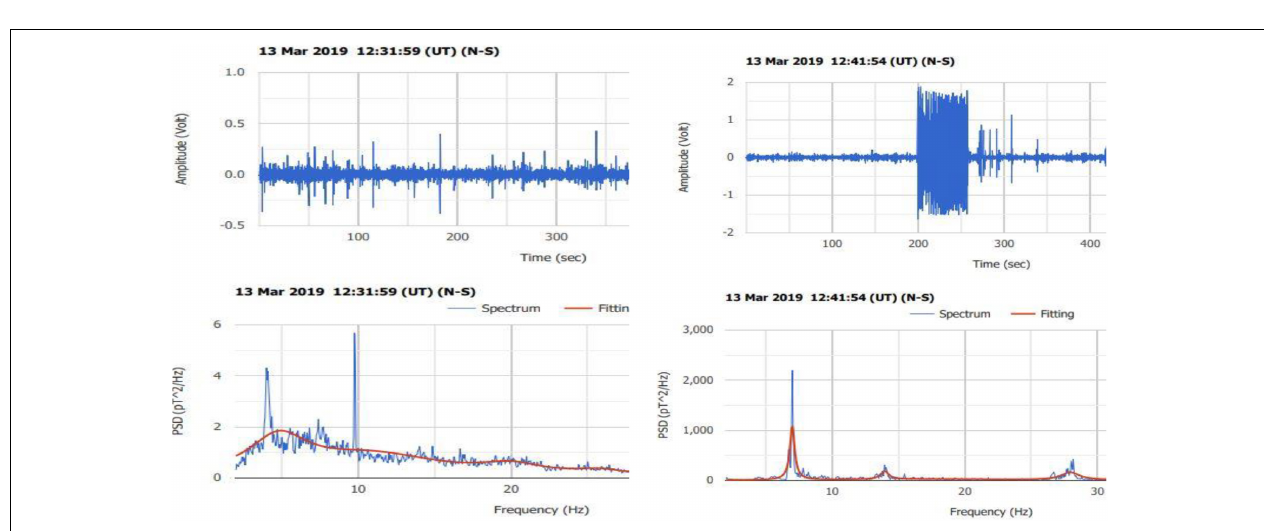
FIGURE 4 | Car engine footprint on the raw data (right panel) , and recording with the engine not running (left panel) .